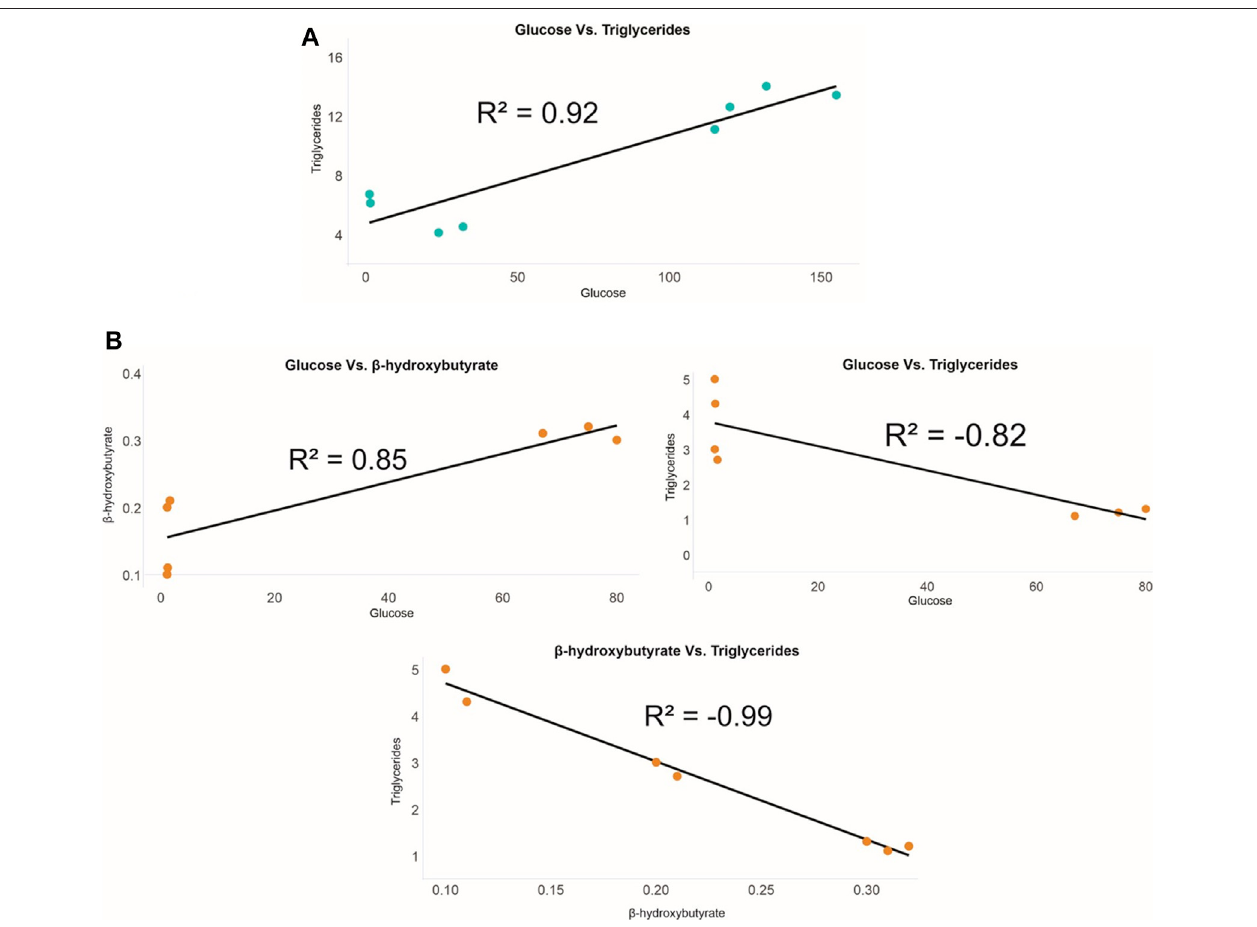
FIGURE 5 | Correlations between P. horkelii energy markers in the (A) uterine liquid of pregnant females (blue) and in the (B) seminal fl uid of sexually active males (orange).